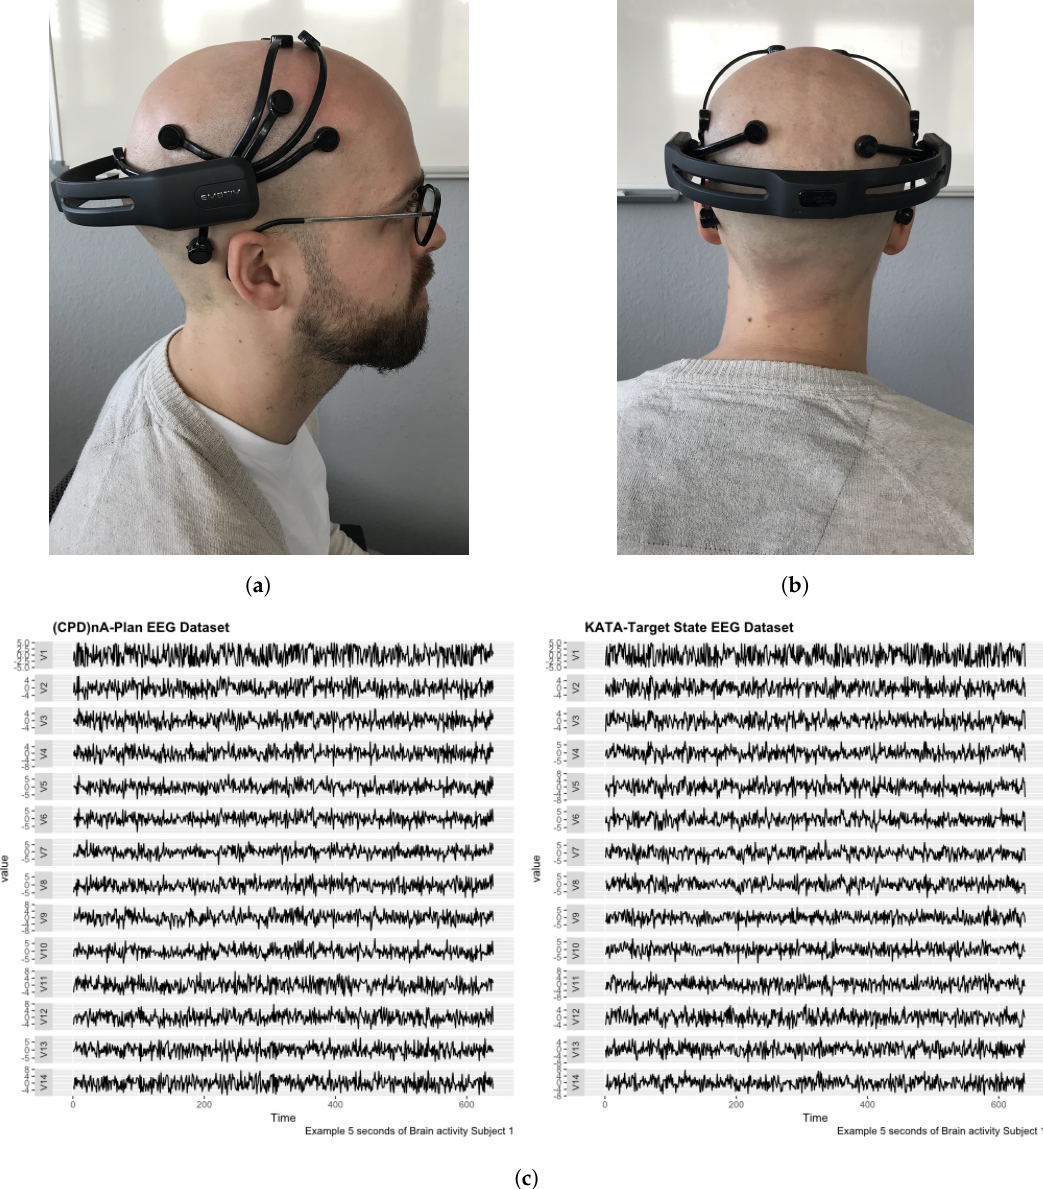
Figure 5. Data Collection. ( a ) EEG Low-Cost Portable Sensor. ( b ) EEG Low-Cost Portable Sensor. ( c ) 5 s recording time series multi-plot of first subject performing (CPD)nA-Plan ( a ) and KATA-III ( b ) of Subject 1